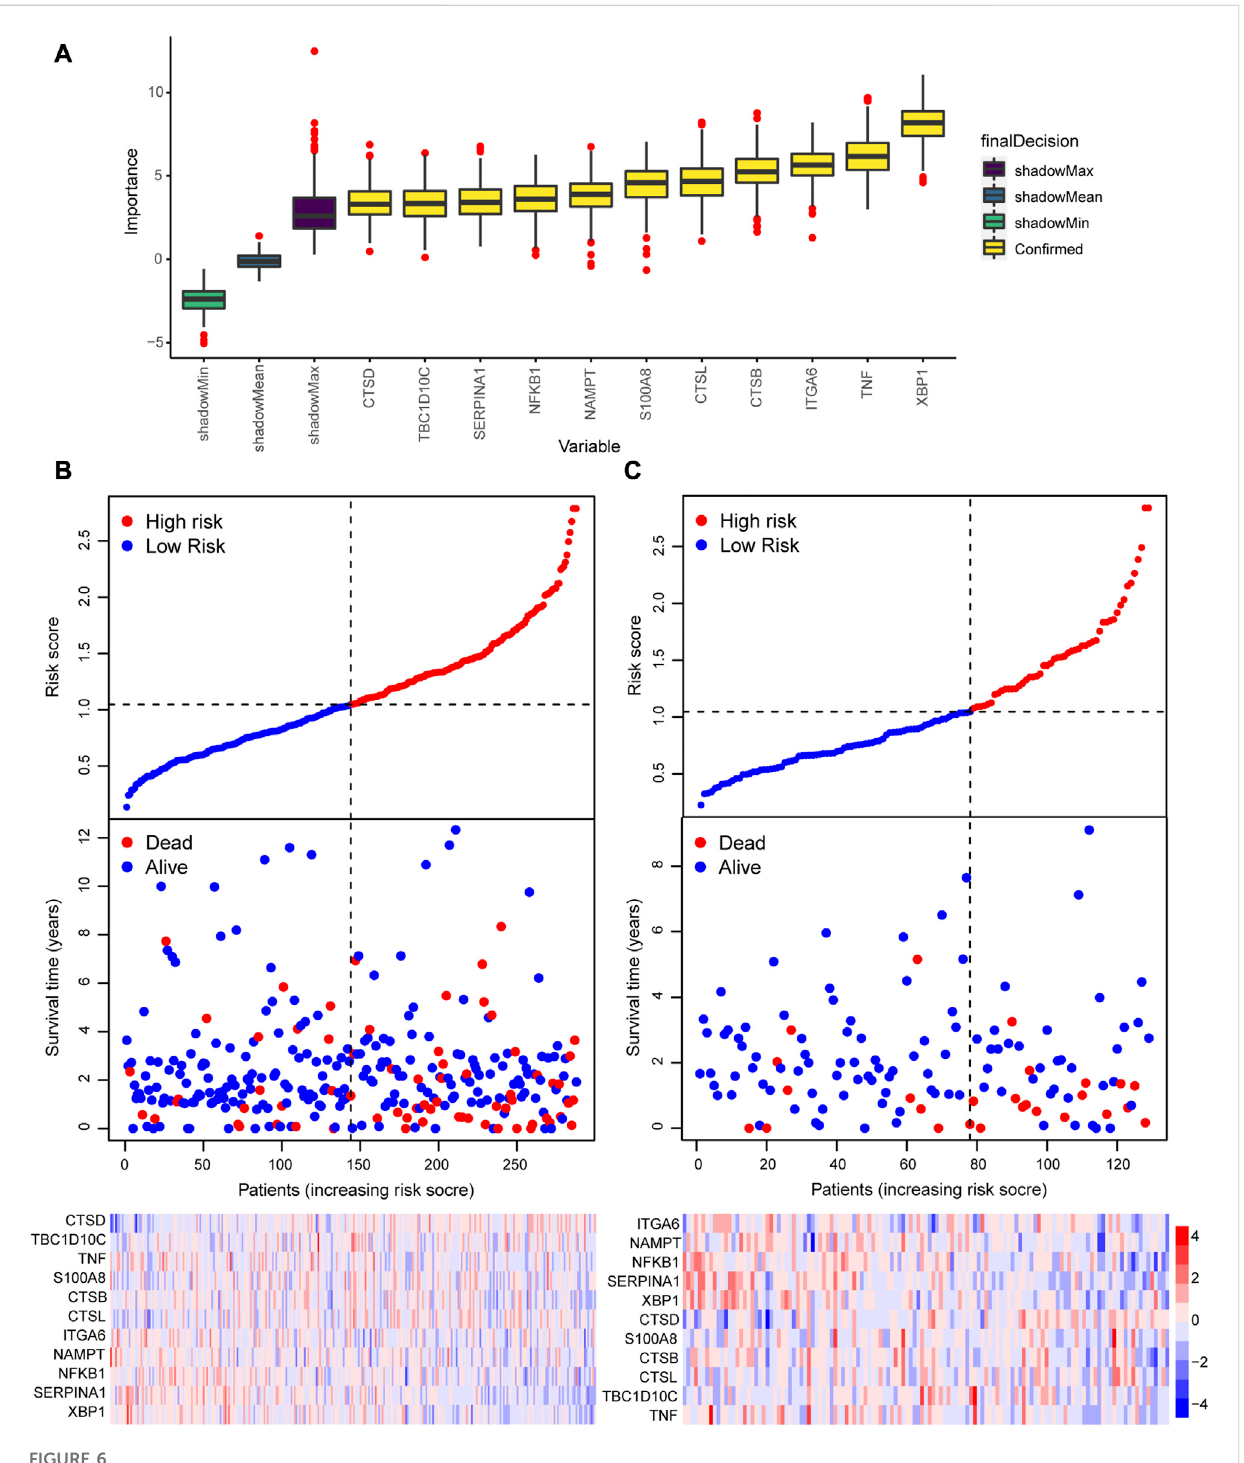
FIGURE 6 Construction of a prognostic model based on the 55 autophagy-related genes (ARGs). (A) Screening of the 11 hub ARGs associated with prognosis based on the Boruta feature. Risk score, survival status, and expression heatmap in the (B) training cohort and (C) validating